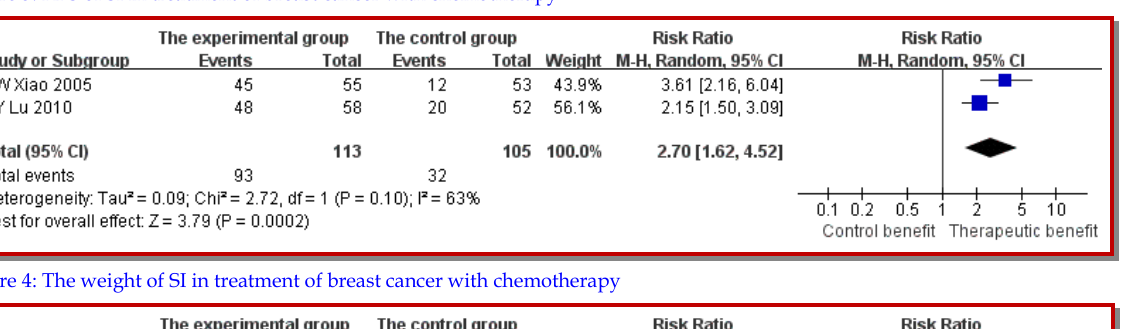
Figure 3: KPS of SI in treatment of breast cancer with chemotherapy